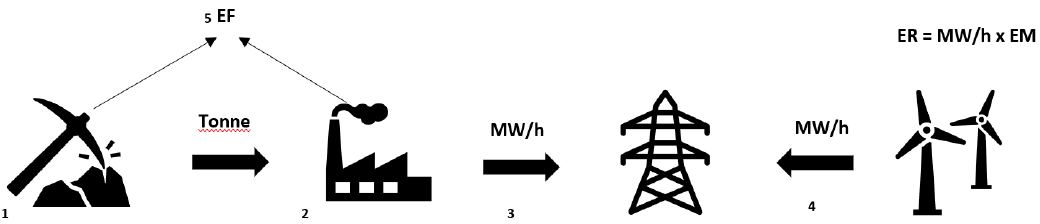
Figure 2. Overview of the sources of emissions, and the process for estimating emission reductions in